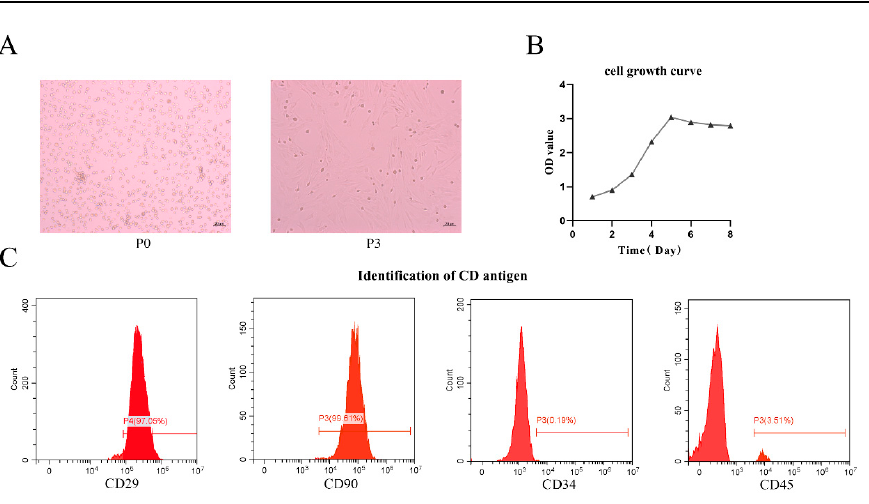
Figure 1. Morphological characteristics of BMSCs. ( A ) Morphological characteristics of BMSCs at P0 and P3 under the microscope (50× magnification). ( B ) CCK-8 staining, demonstrated the proliferative capability of BMSCs. ( C ) Flow cytometry analysis for CD29, CD90, CD34 and CD45 expression, to identify BMSCs.